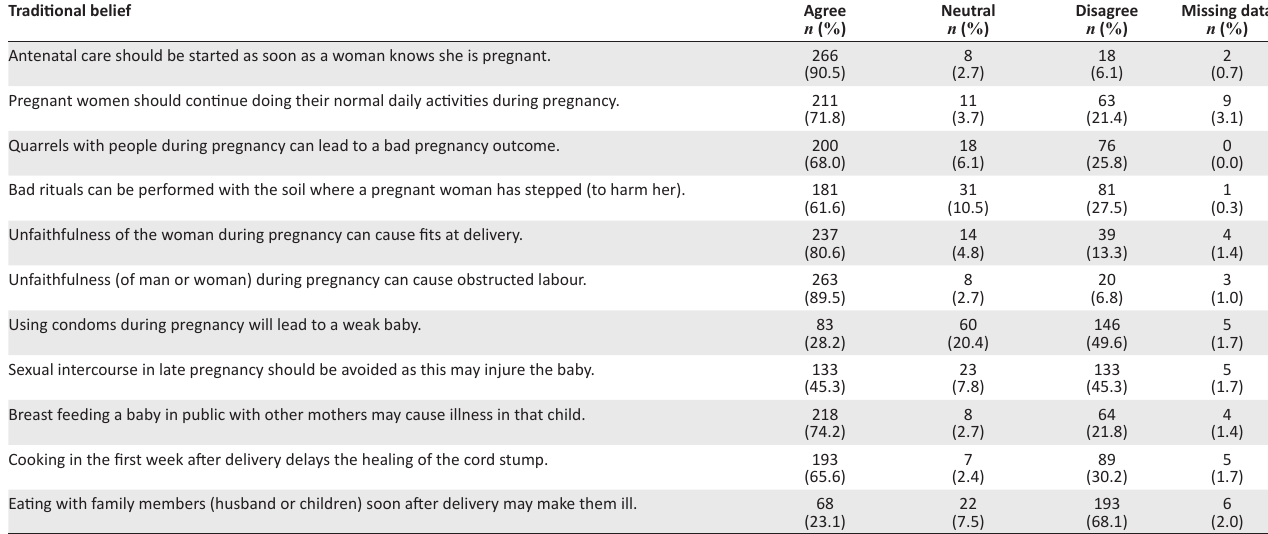
Neutral Disagree Missing data n ( % ) n ( % ) n ( % ) n ( % )